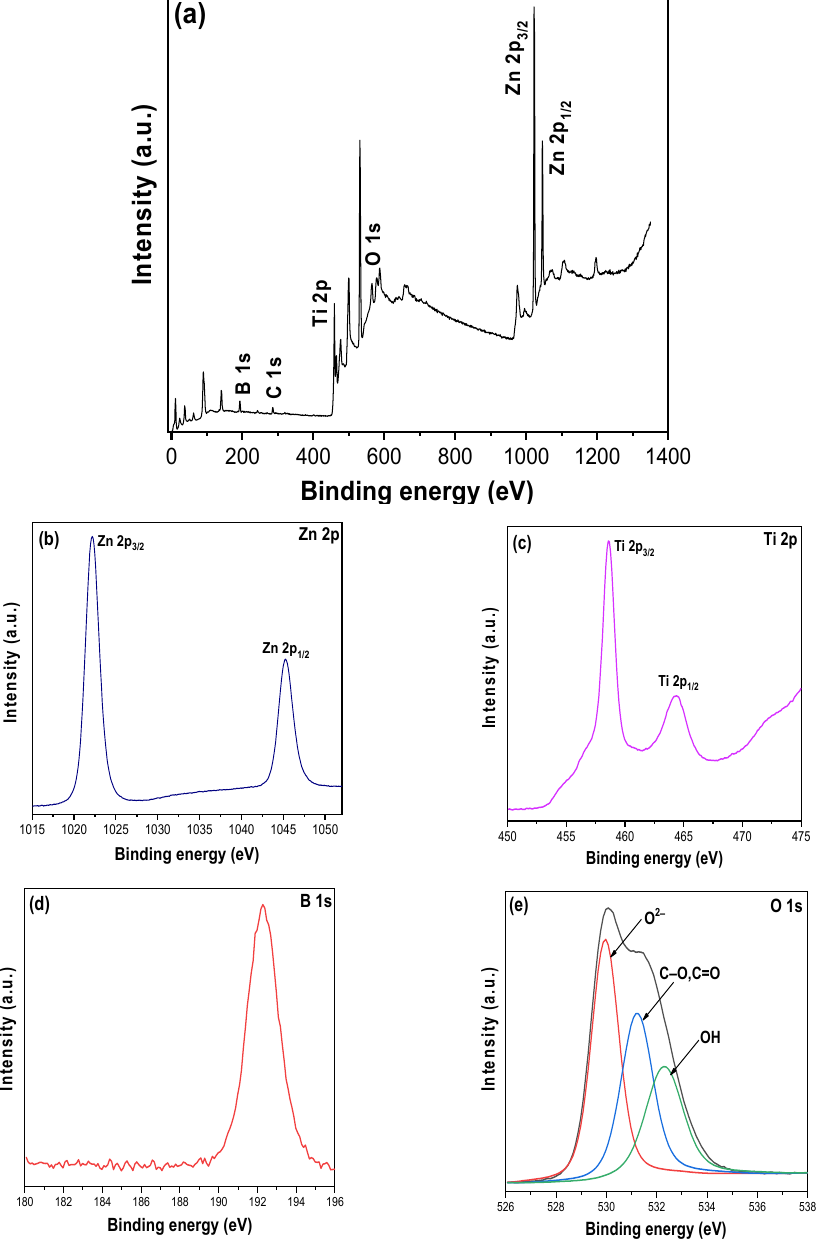
Figure 7. XPS spectra of B–ZnO/TiO 2 ( a ) survey, ( b ) Zn 2p, ( c ) Ti 2p, ( d ) B 1s, and ( e ) O 1s.